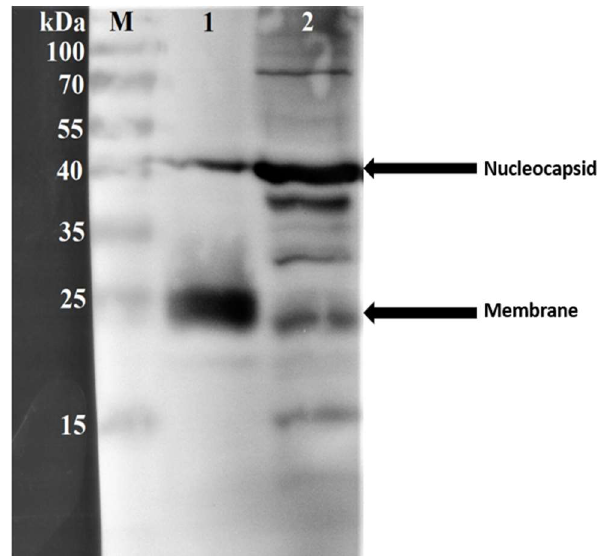
Figure 2. Identification of HCoV-NL63 Nucleocapsid (N) and Membrane (M) proteins. Western blot analysis of the purified HCoV-NL63 antigen (lane 1) compared to HCoV-NL63 protein recovered from transfected LLC-MK2 whole cell lysate (lane 2). Lane M shows the molecular weight standard in Kilodaltons.